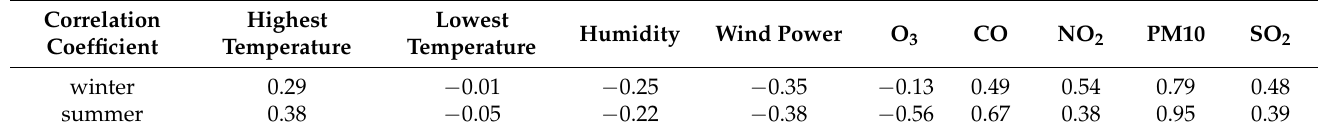
Table 1. Correlation coefficient value of PM2.5 and meteorological